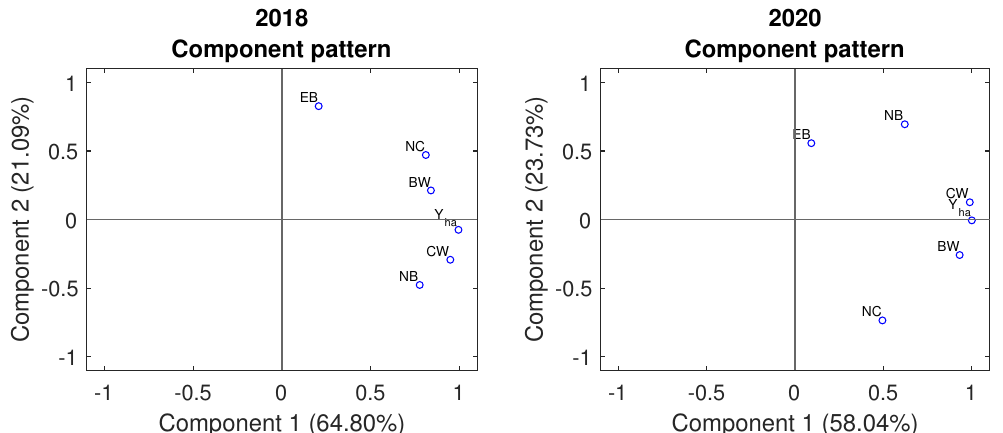
Figure 4. Principal component analysis of yield quantity and quality of Regent grapevines irrespective of rootstock type considered in the extreme years of the study.